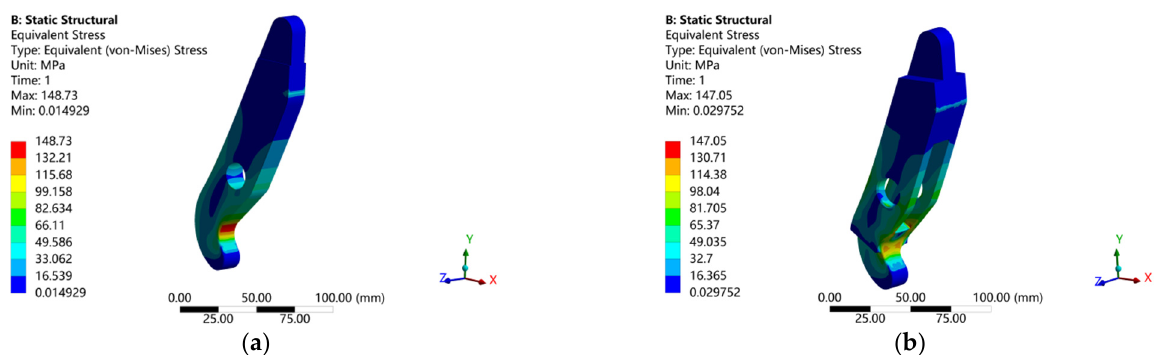
Figure 17. ( a ) Von Mises stress cloud map of the right fork of the hook; ( b ) von Mises stress cloud map of the left fork of the hook.